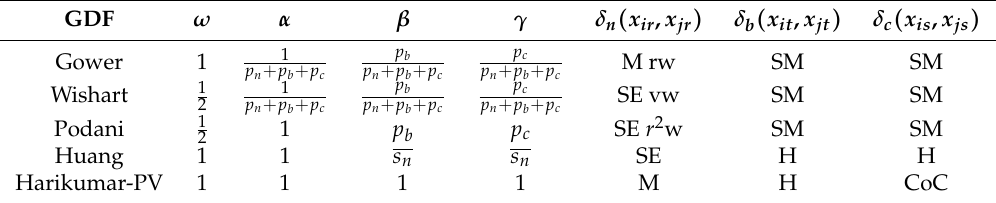
Table 1. Mixed variable distances in the GDF